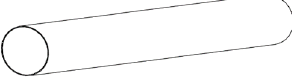
Figure 9. Single periodic structure.